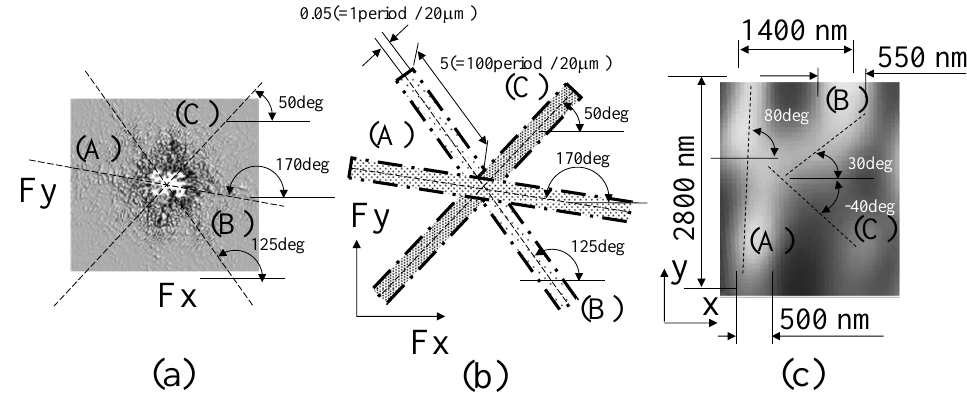
Figure 12. Design of the filter for two-dimensional analysis. ( a ) Information of image of alphabet character “K” in frequency domain; ( b ) Passband of the filter; ( c ) Measured result using the filter.